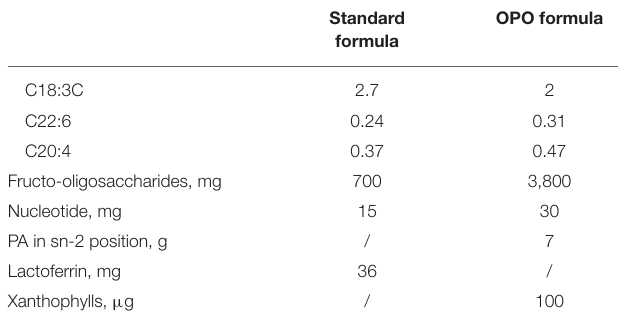
TABLE 1 | Compositions of the standard formula and OPO